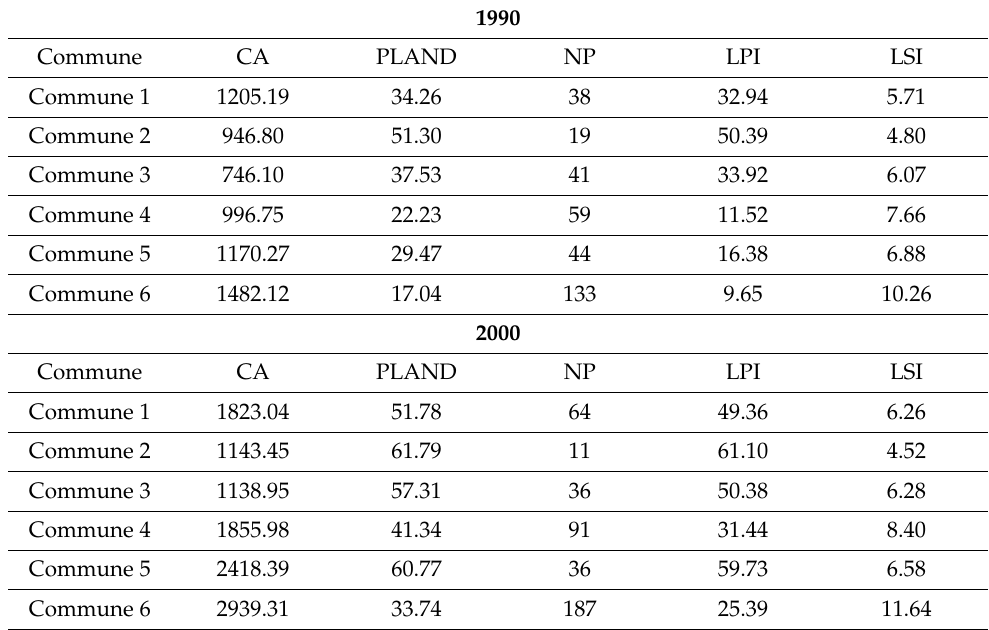
Table 11. Landscape metrics at class level for built-up between communes in Bamako.